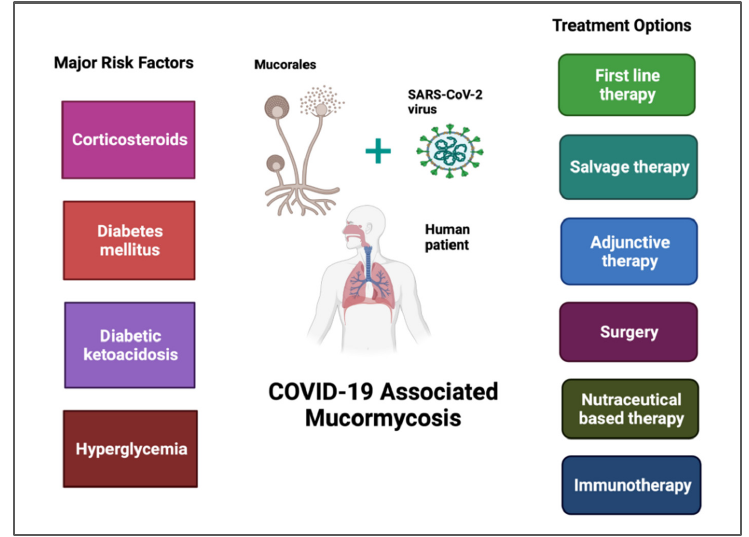
Figure 2. COVID ‐ 19 ‐ associated mucormycosis. Left Column: Major risk factors include corticosteroids, DM, DKA, and hyperglycemia. Right Column: Treatment options include first ‐ line therapy (liposomal amphotericin B and amphotericin B deoxycholate), salvage therapy (isavuconazole, itraconazole, and posaconazole), adjunctive therapy (iron chelators (lactoferrin), saturated solution of potassium iodide, statins, and anti ‐ inflammatory drugs (Aspirin)), surgery (debridement), nutraceuticals, and immunotherapy (IFN ‐γ , anti ‐ CotH3 antibodies, IL ‐ 2 pre ‐ stimulated NK cells, and G ‐ CSF mobilized granulocyte transfusion). Created with BioRender.com.